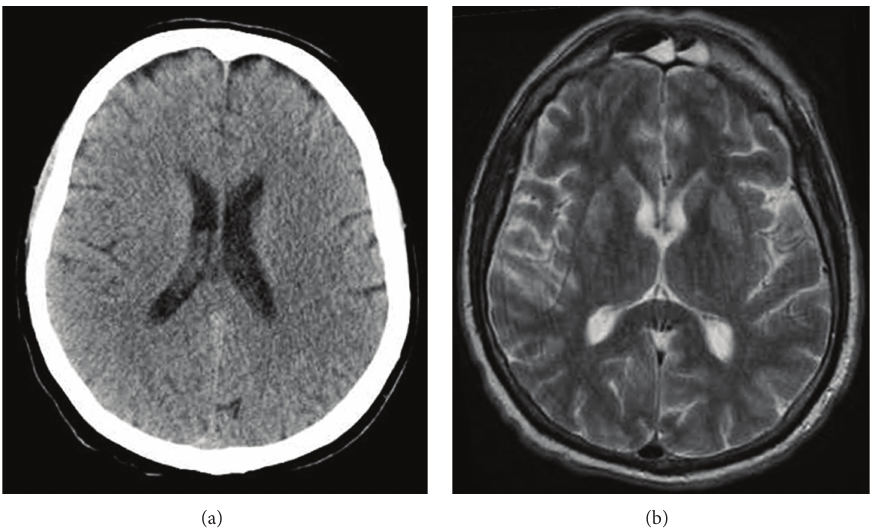
Figure 2: (a) An urgent cranial computed tomography scan was negative for cerebral oedema, hemorrhage, and structural lesions. (b) The magnetic resonance imaging, obtained three weeks after the initial event, demonstrated a mild hyperintensity in the lenticular nuclei and periventricular areas bilaterally in T2 sequences.